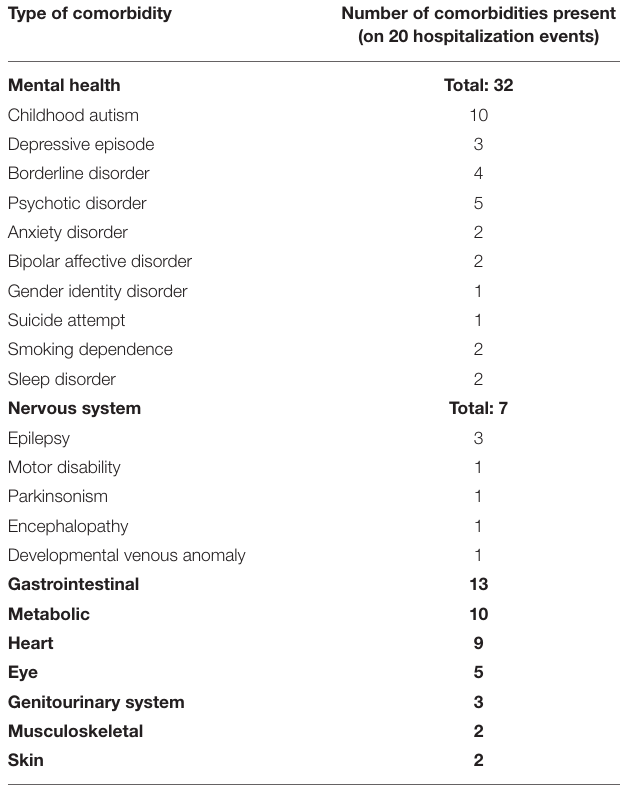
TABLE 3 | Types and number of comorbidities in the study sample (on 20 hospitalization